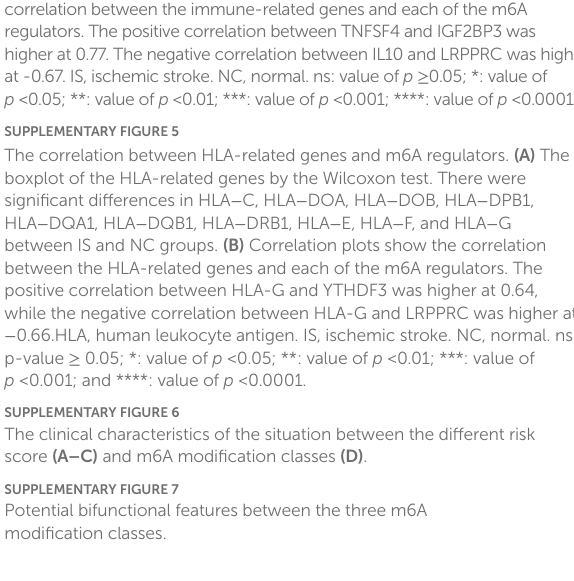
SUPPLEMENTARY FIGURE 1 Landscape of m6A regulators in ischemic stroke. (A) The Circos diagram of the 23 m6A genes. (B) The PPI network of 23 m6A genes. SUPPLEMENTARY FIGURE 2 Correlation of m6A regulator expression. (A,B) Correlation diagram of m6A gene between IS samples and all samples, respectively, with darker colors indicating stronger correlations and spaces indicating statistical p ≥ 0.05 and not reaching significance levels. SUPPLEMENTARY FIGURE 3 The expression of the M6A-related diagnostic model genes. (A-D) The expression of ELAVL1, ALKBH5, LRPPRC, METTL14 were downregulated while (E-G) the expression of YTHDF2, YTHDC1 and IGF2BP2 was upregulated in IS compared with healthy controls. *: value of p < 0.05; **: value of p <0.01; ***: value of p <0.001. SUPPLEMENTARY FIGURE 4 The correlation between immune-related genes and m6A regulators.